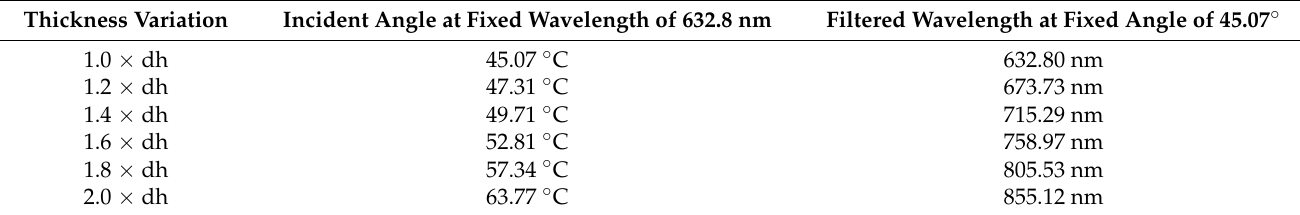
Table 1. Effect of thickness variation on both incidence angle and excitation